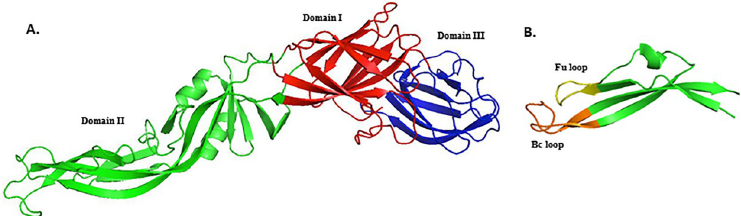
Fig 3. Cartoon structure of dengue envelope protein and recombinant FuBc protein. A) Structure of partial dengue envelope protein (PDB ID. 1OAN). B) Homology model of recombinant FuBc